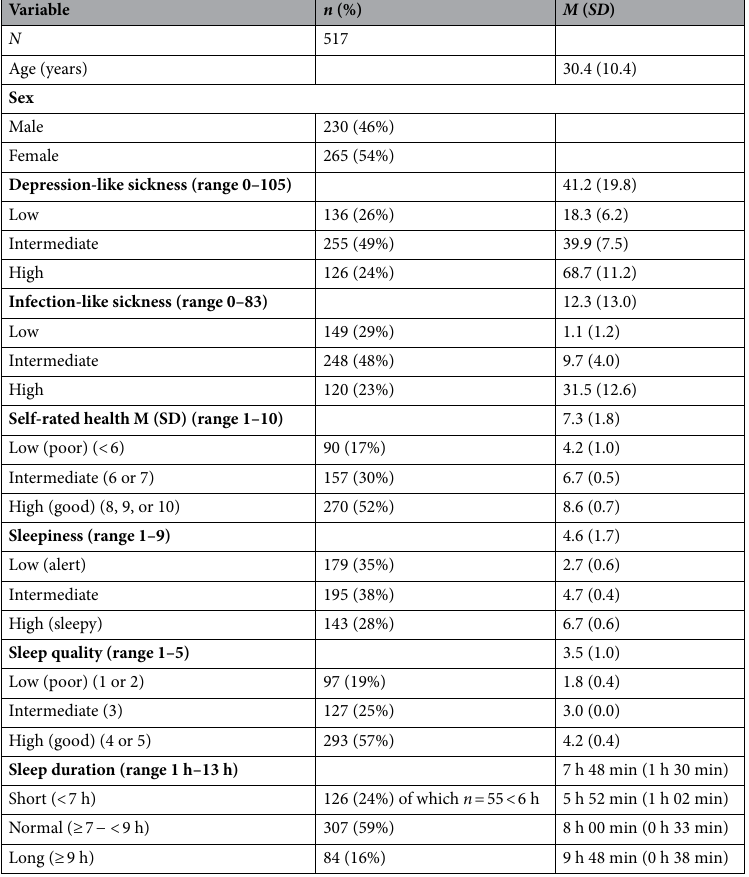
Table 1. Descriptive characteristics of the study population given as sample size ( n ) and percentage (%), and mean ( M ) and standard deviation ( SD ). Percentages may not total 100 due to